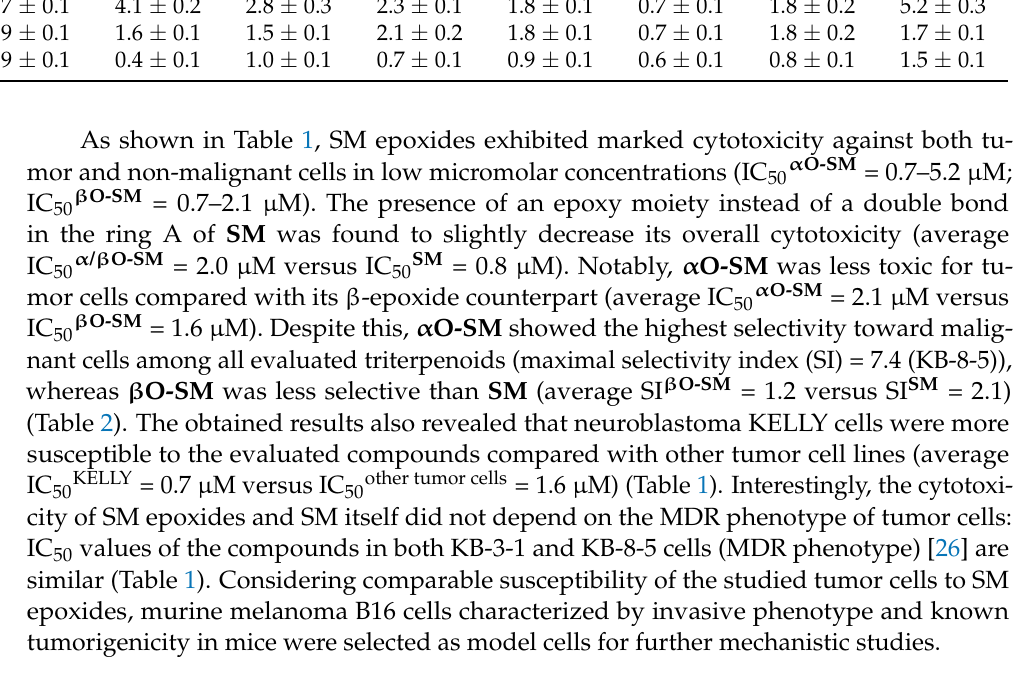
Table 2. Selectivity index (SI) of SM and its novel epoxide